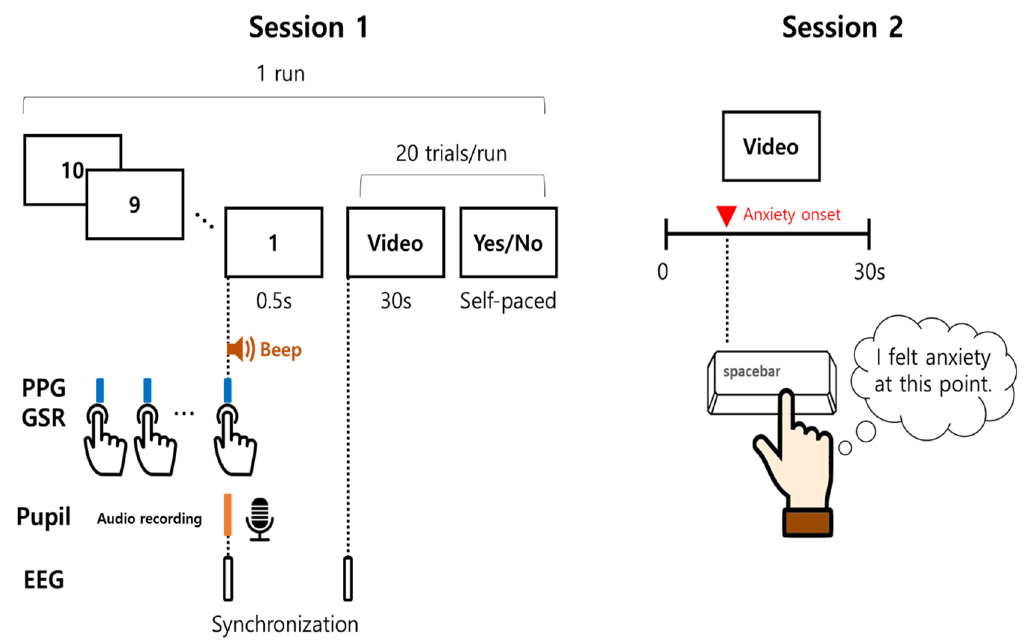
Figure 1. Experimental task and multimodal biosignal recording. In Session 1, participants watched video clips with or without anxiety events and answered whether they felt anxiety. In Session 2, participants indicated a point where in the video they felt anxiety.